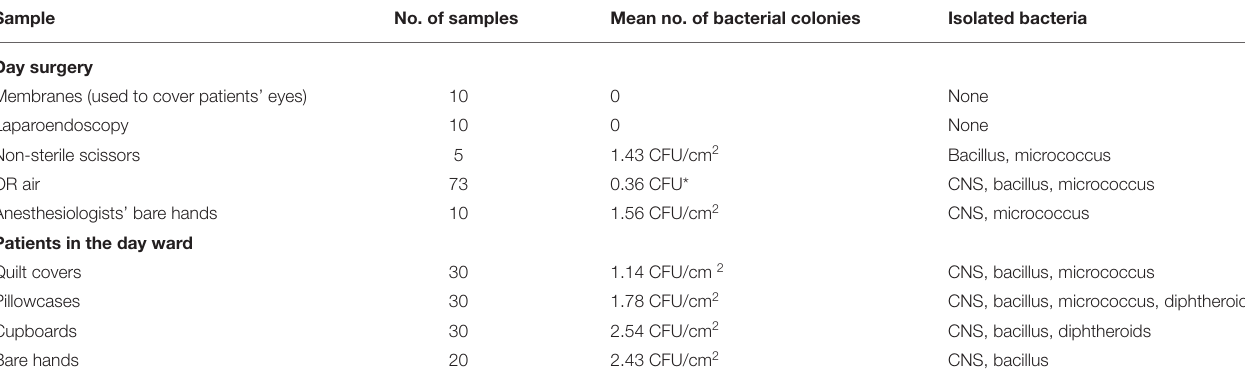
TABLE 1 | Mean bacterial colony counts and isolated bacteria from 218 samples from day surgery and the day ward. Sample No. of samples Mean no. of bacterial colonies Isolated